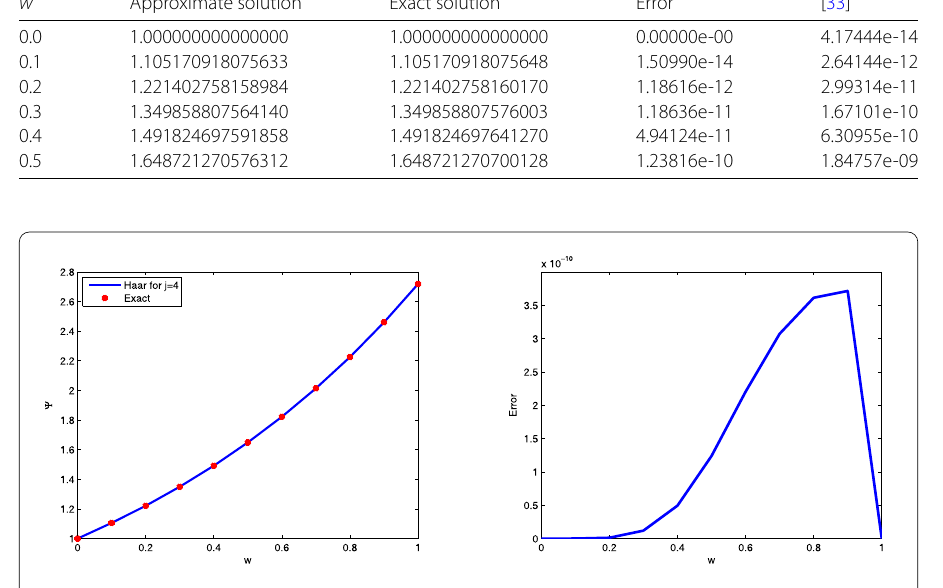
Figure 6 Solution profile of Example 5.6 for J = 4